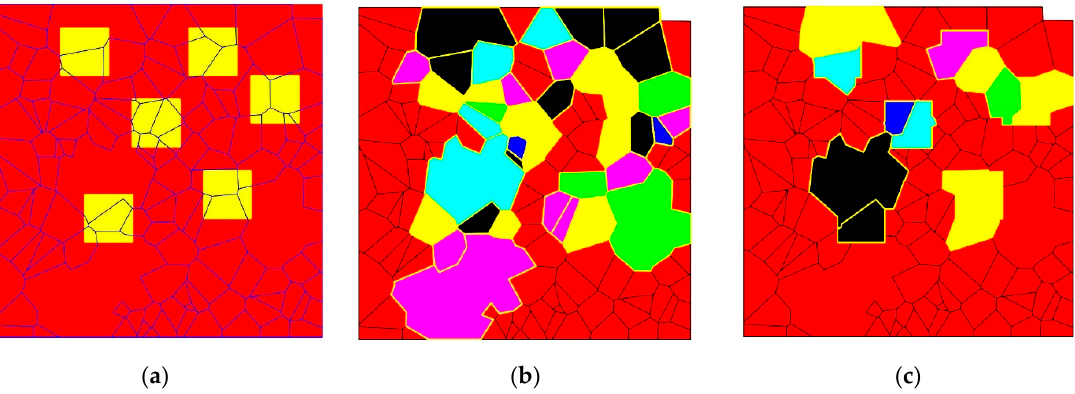
Figure 2. ( a ) Generation of Voronoi diagrams (as propagated cracks) on a virtual two-phase ore (red phase as matrix and yellow phase as grains); ( b ) the shape of mixed particles after random breakage, ( c ) the shape of mixed particles after preferential breakage.